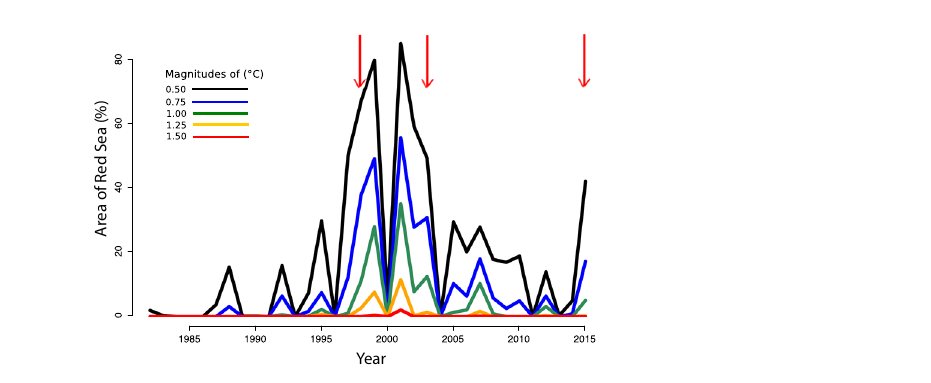
Figure 6. Percent of Red Sea area exhibiting maximum annual temperature (T max ) anomalies of different magnitudes between 1982 and 2015. Red indicators signal the occurrence of El Niño